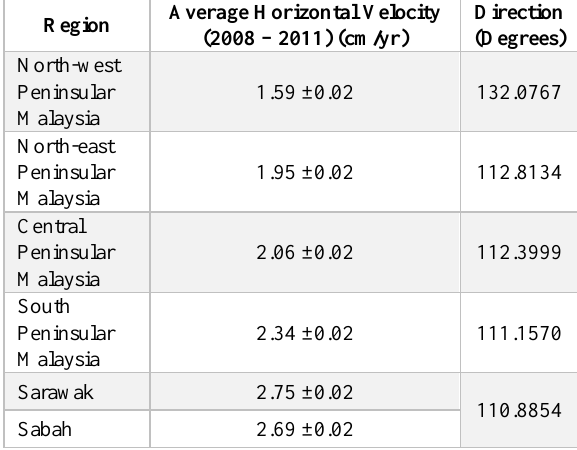
Table 2. Averaged horizontal velocities of Malaysia by